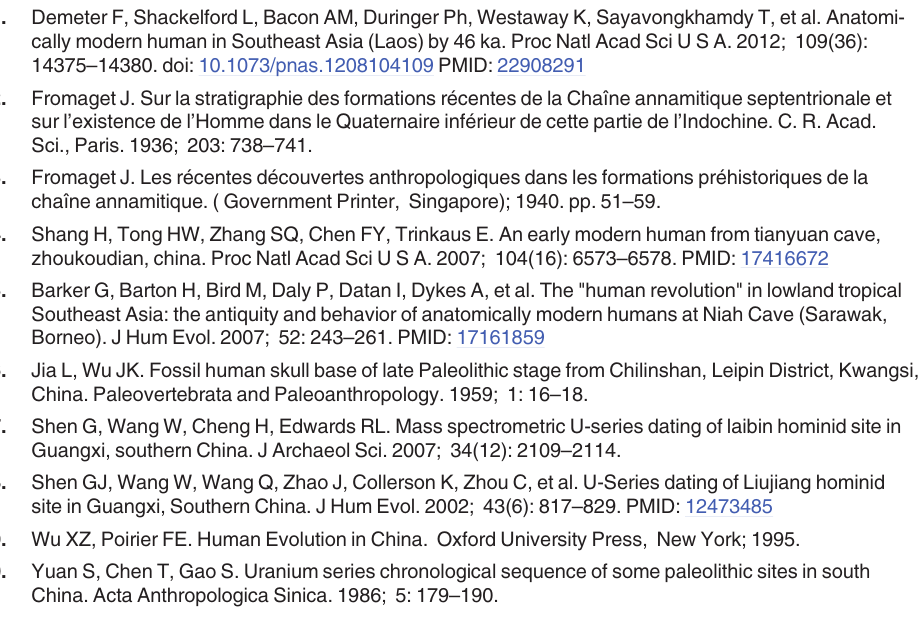
S9 Table. Rodent faunal list for Tam Pa Ling. On the 366 remains, 249 have been identified as shown in the table (NISP). The 27 remains of undetermined Murinae could be grouped as small, medium and large size murin, with the calculated MNI for each